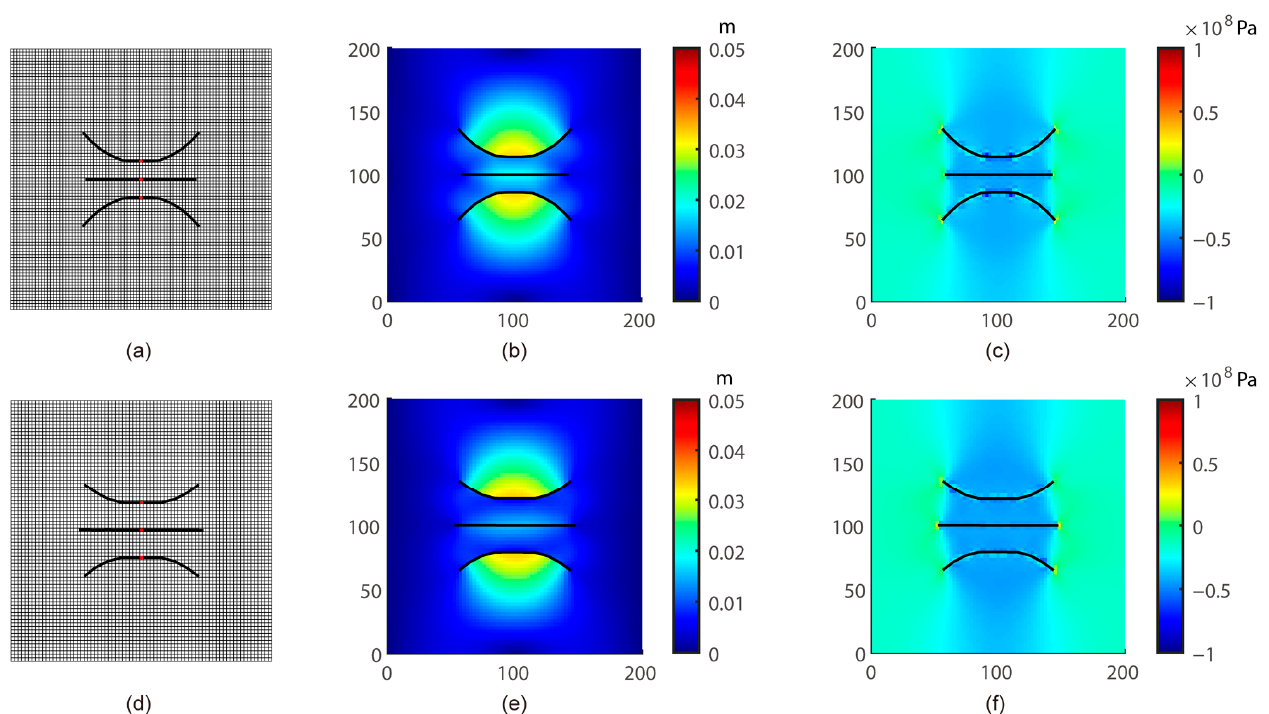
Figure 10. Simulation results with fracture spacing = 14 or 21 m after 280 s, ( a ) Fracture final mor- phology of spacing = 14 m, ( b ) Displacement of spacing = 14 m, and ( c ) Effective stress component σ′ spacing = 14 m, ( d ) Fracture final morphology of spacing = 21 m, ( e ) Displacement of spacing = 21 m, and ( f ) Effective stress component σ′ y of spacing = 21 m.